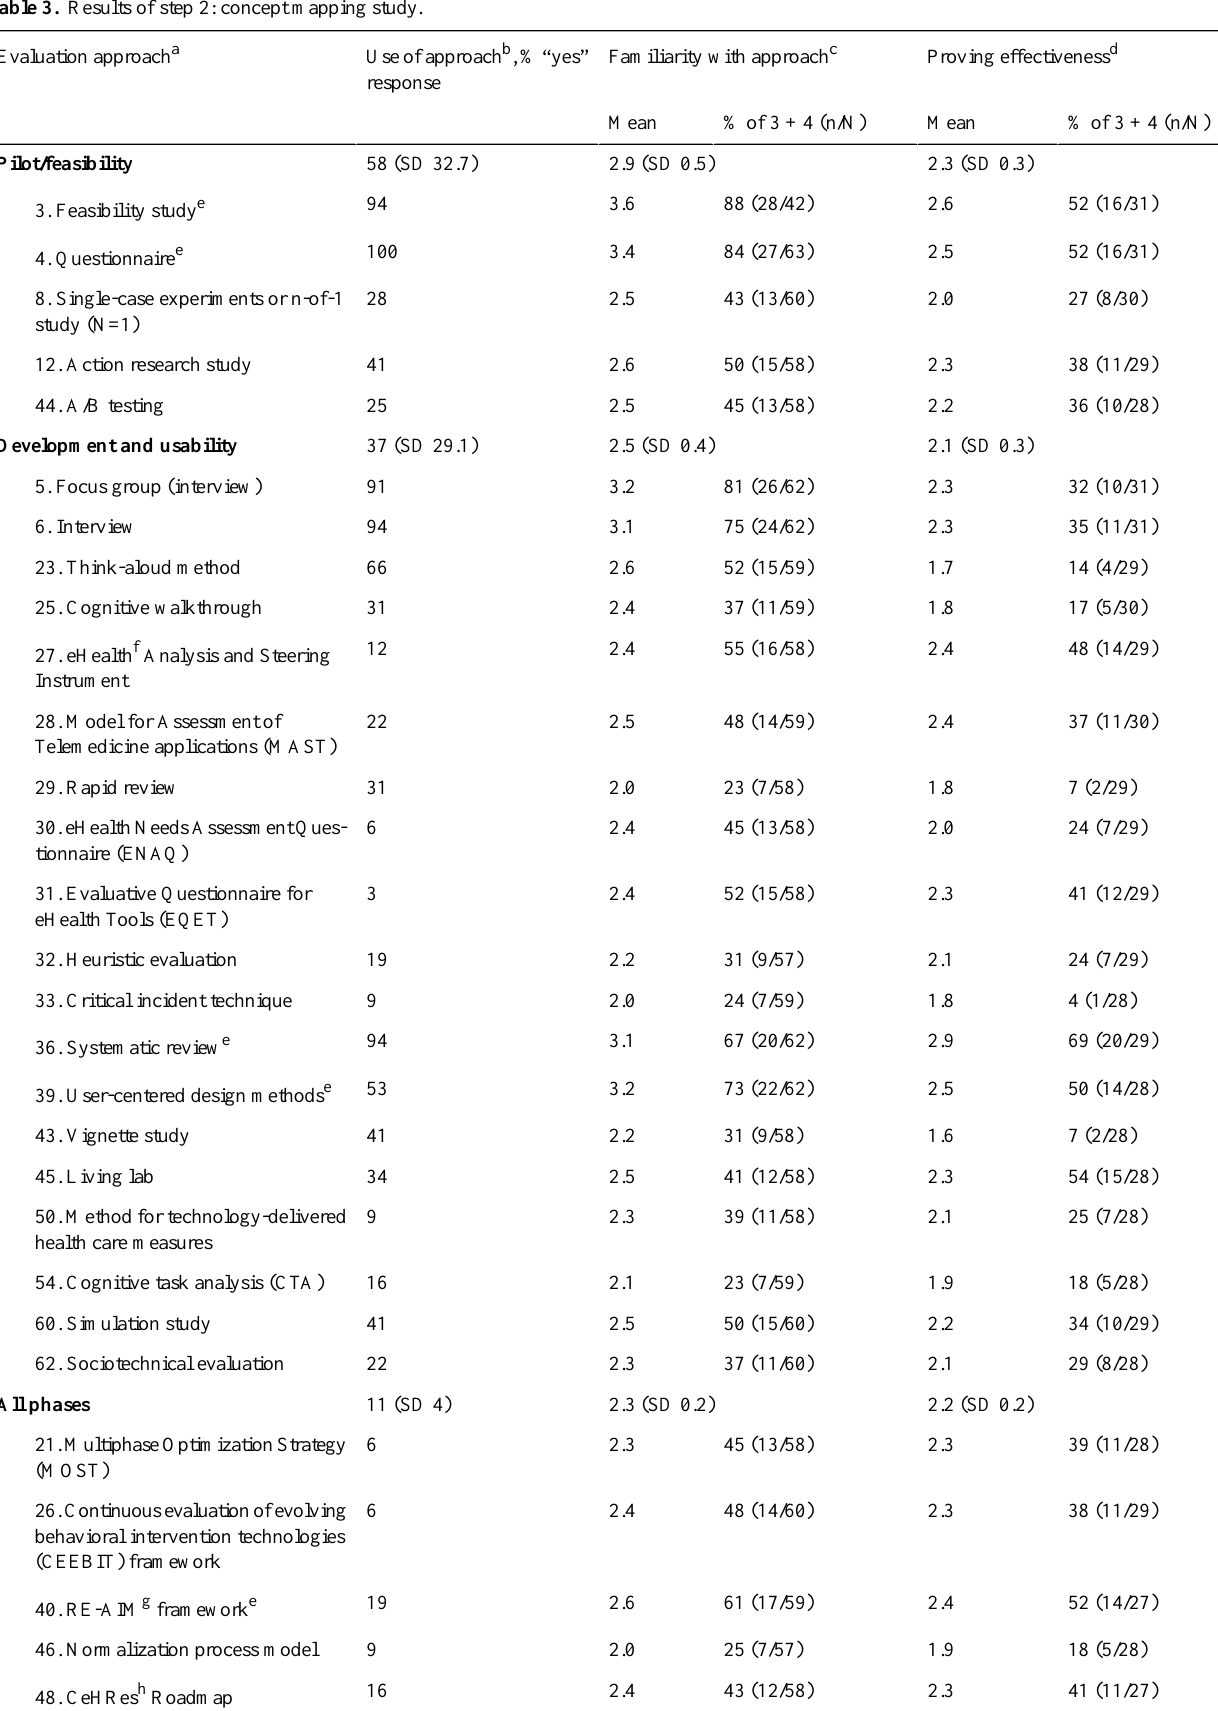
Table 3. Results of step 2: concept mapping